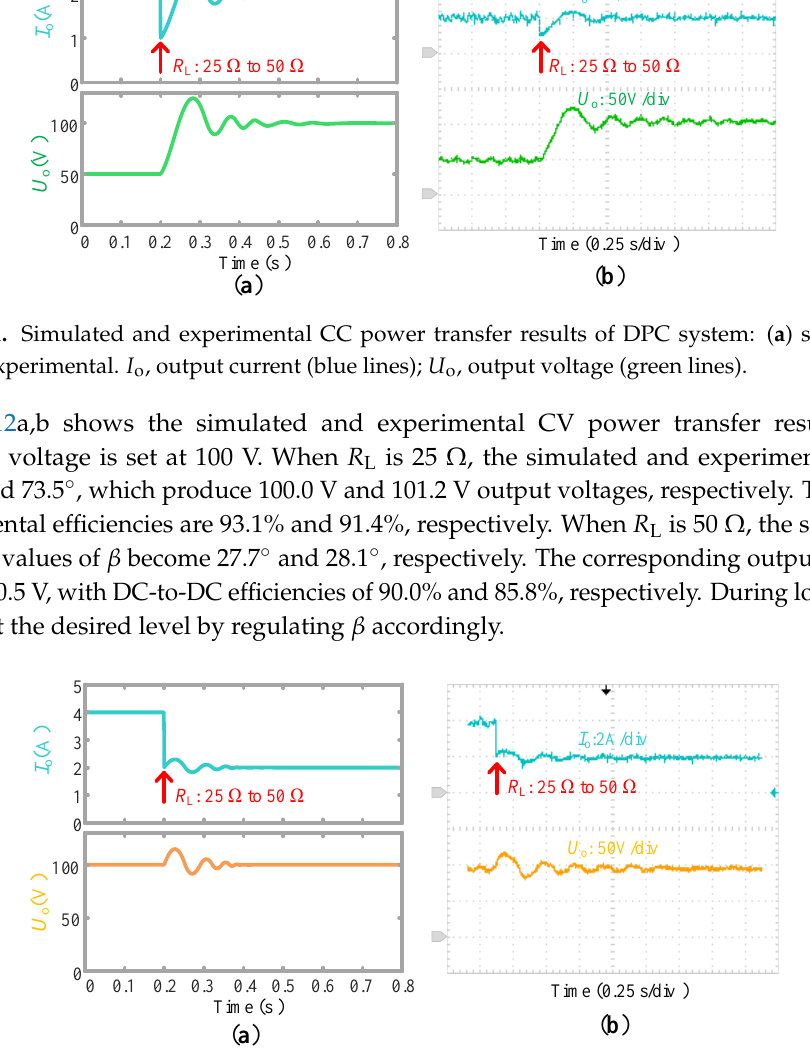
Figure 12. Simulated and experimental CV power transfer results of DPC system: ( a ) simulated; and ( b ) experimental. I o , output current (blue lines); U o , output voltage (yellow lines).